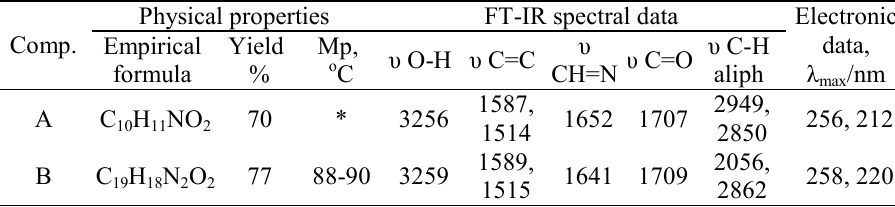
Table 1. Physical, FT-IR and electronic spectral data of compounds A and B.